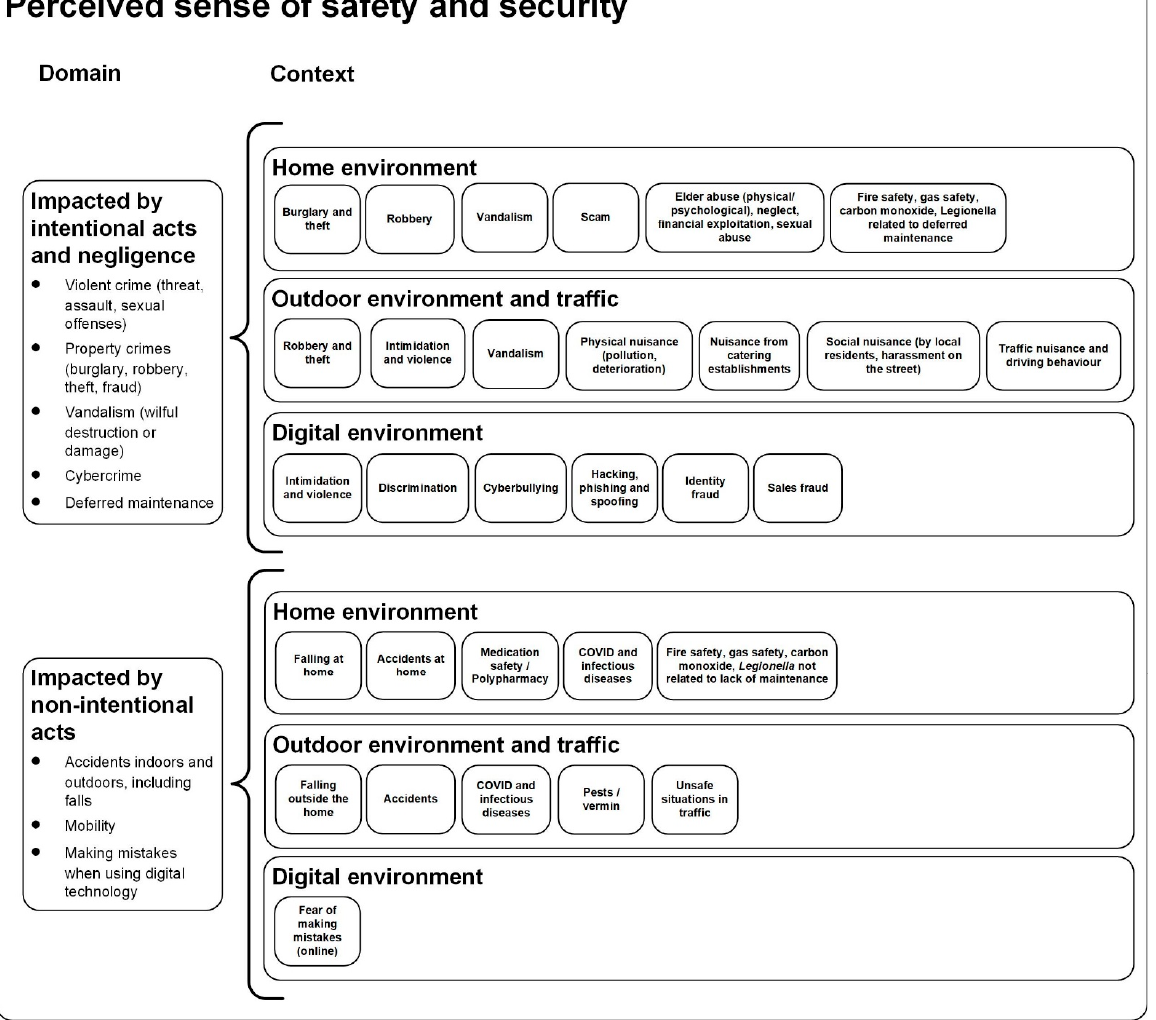
Figure 2. Classification of the perceived sense of safety and